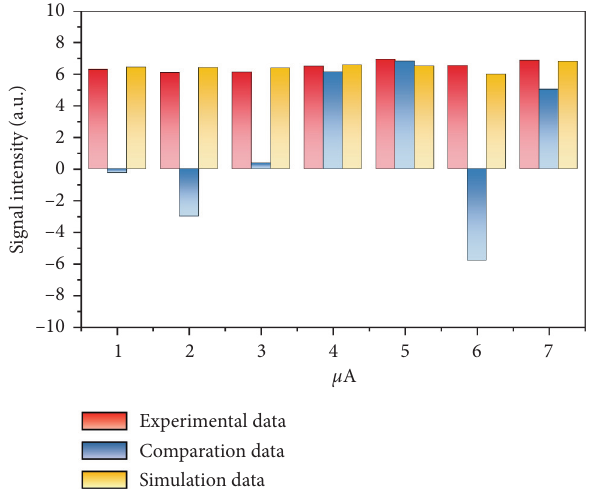
Figure 6: Measurement of the response signal of the standard S2 sensor.